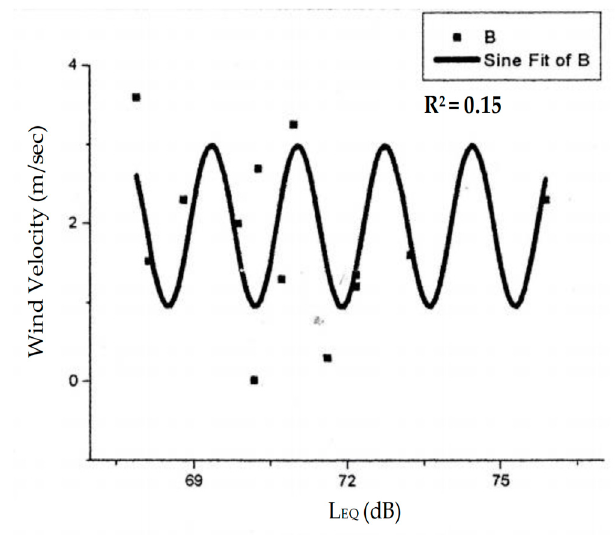
Figure 13. Correlation modeling between Relative Humidity and Noise Level at OS-T. Table 17. Correlation modeling between Relative Humidity and Noise Level at CW-T.